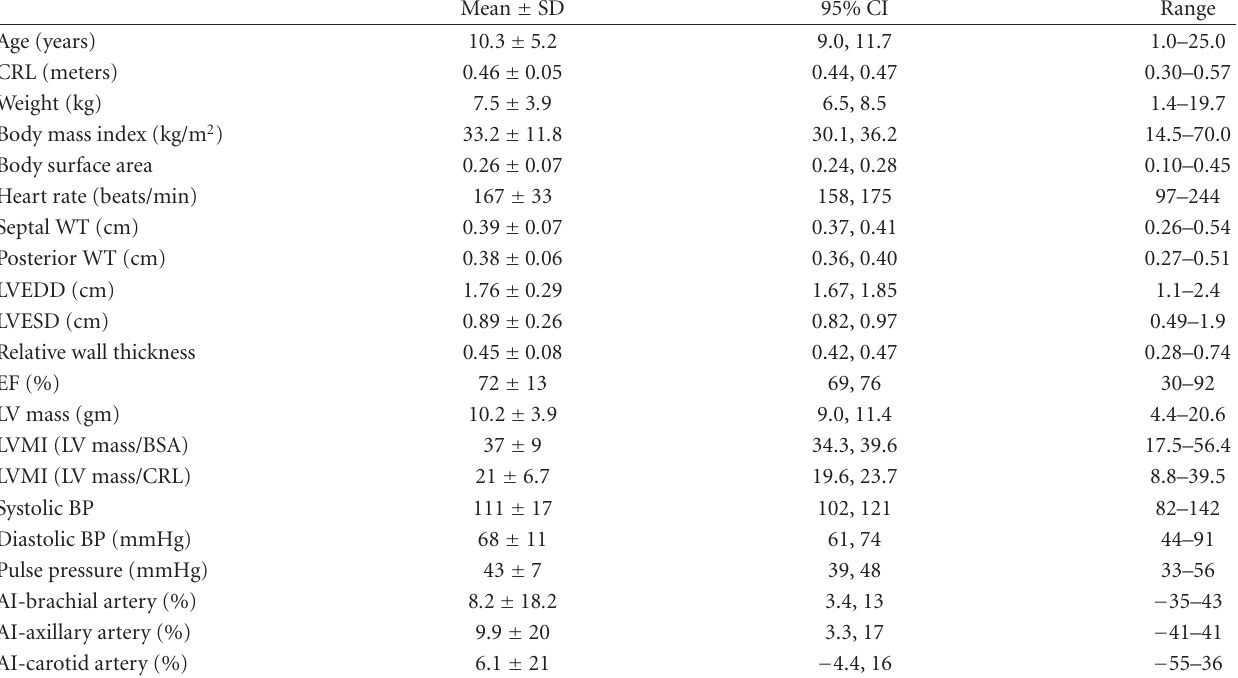
Table 1: Clinical and echocardiographic measurements in 61 bonnet